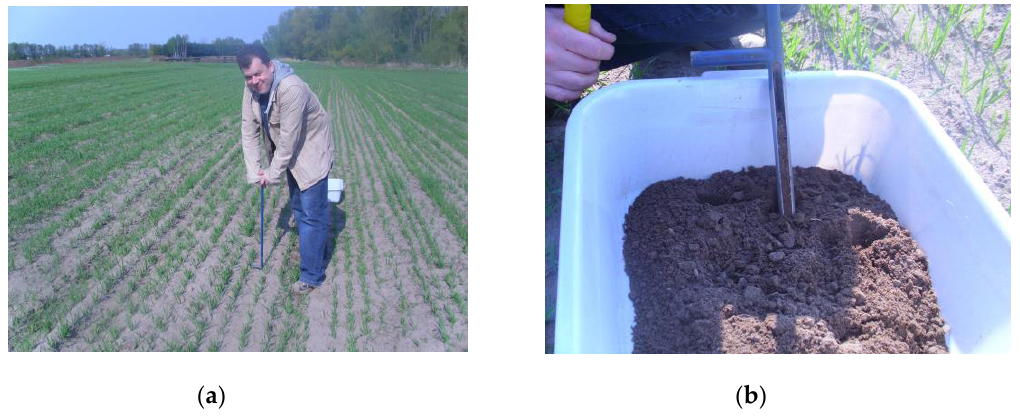
Figure 1. Soil sampling with Egner’s bow by Dr. Artur Banach from The John Paul II Catholic University of Lublin ( a ), and homogenization of single random samples into one representative sample ( b ) in each site separately.